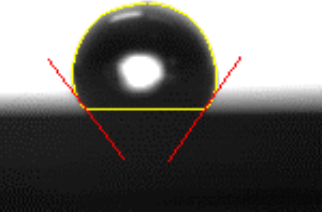
Figure 8. Contact angle measurement result.